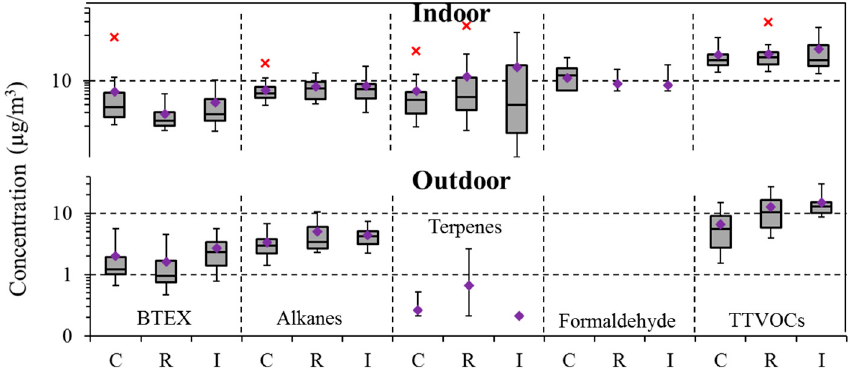
Figure 4. Box plots of BTEX, alkane, terpene, formaldehyde, and TTVOC concentrations indoors and outdoors by community type: no-local emission source or clear (C), road (R), and industrial (I). Plots show 5th, 25th, 50th, 75th and 95th percentile concentrations. Diamond ( ♦ ) denotes mean. Asterisk (x) denotes outliers.